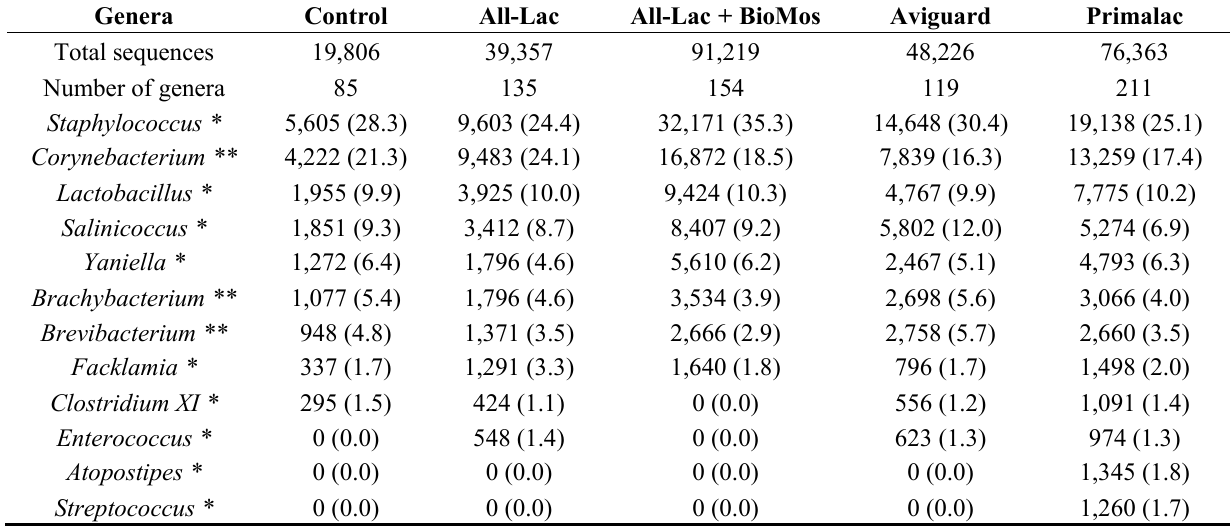
Table 6. Abundance and prevalence of genera comprising litter bacterial community of broiler chickens raised in research housing and administered probiotics or prebiotics. Number of 16S rRNA sequences exhibiting 97% similarity to each genus is shown with the percentage of sequences in parentheses.